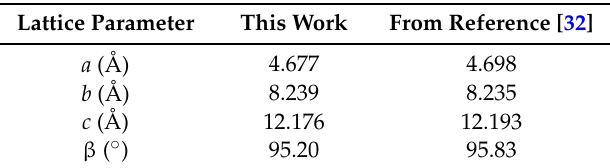
Table 4. Zr 2 Ni 7 unit-cell lattice